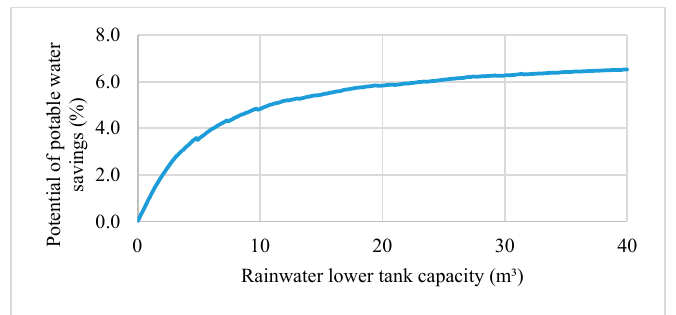
Figure 10. Potential for potable water savings as a function of the current rainwater tank capacities used in the building.